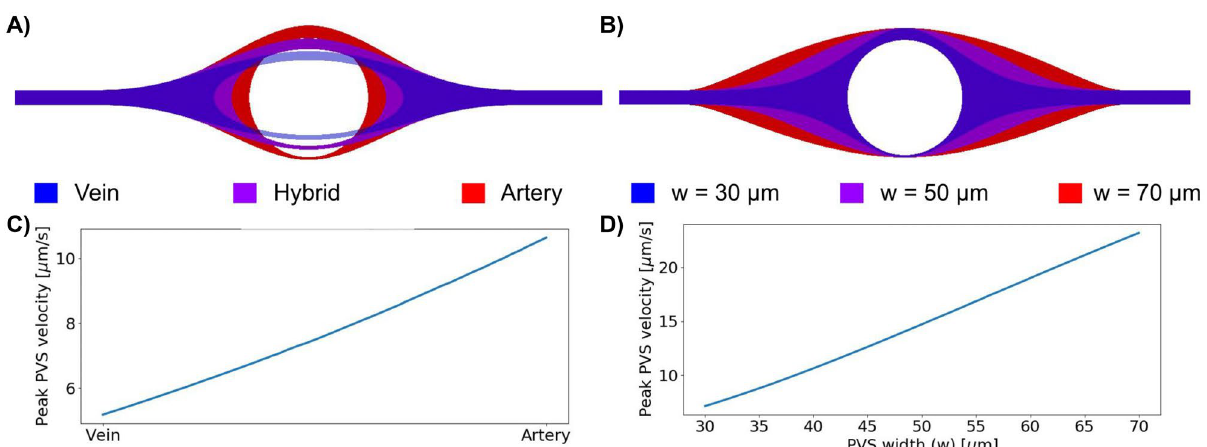
Figure 5. The effect of geometry change on maximal PVS velocity. ( A ) shows a gradual change from a venous to an arterial PVS. ( B ) shows change in PVS width for the arterial geometry. Maximal PVS velocities as a function of linear change in geometry is shown for the change from artery to vein ( C ), and changes in PVS width ( D ).In both cases the maximal PVS velocity increased linearly with changes in the